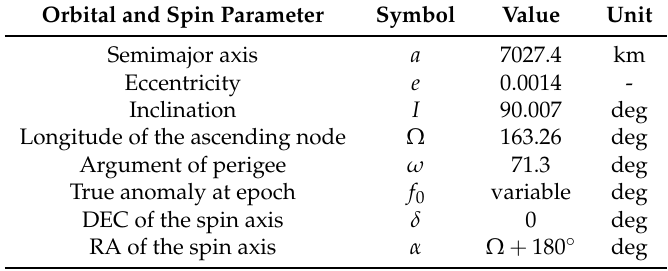
Initial conditions common to all the numerical integrations. They were retrieved from Kahn [25] for GP-B. The true anomaly at epoch f 0 is changed from one run to another.